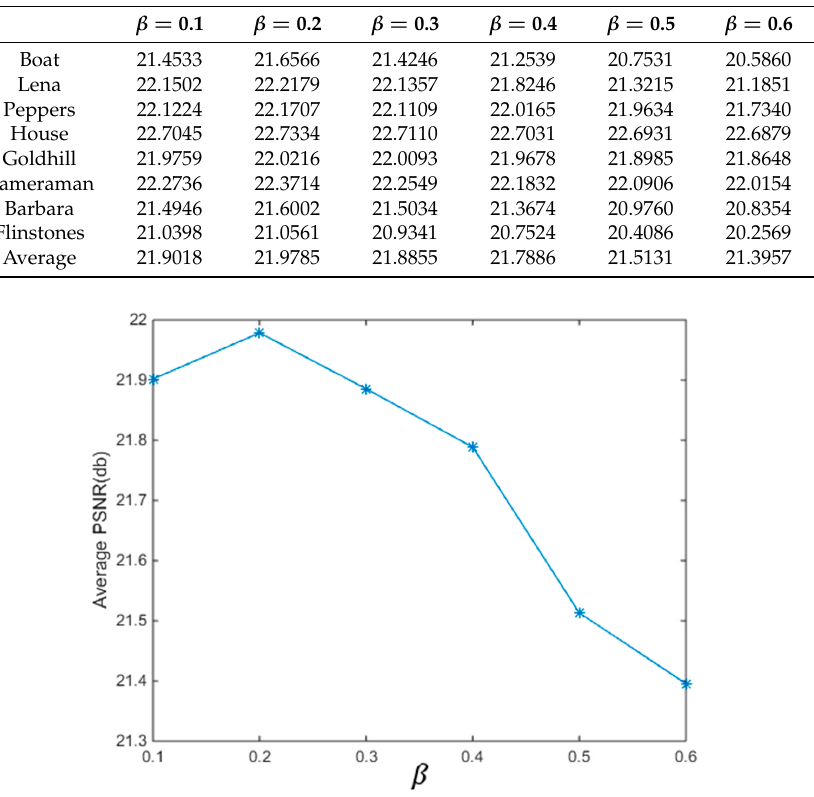
Figure 5. The average PSNR values with respect to the parameter β